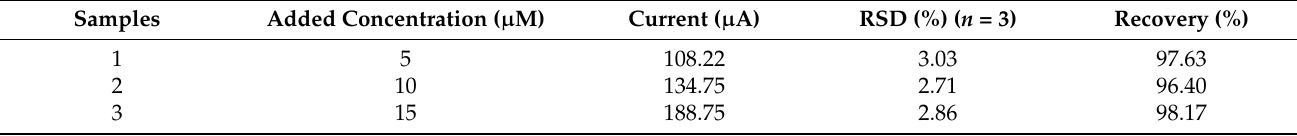
Table 3. Determination of 4-AP in water samples.